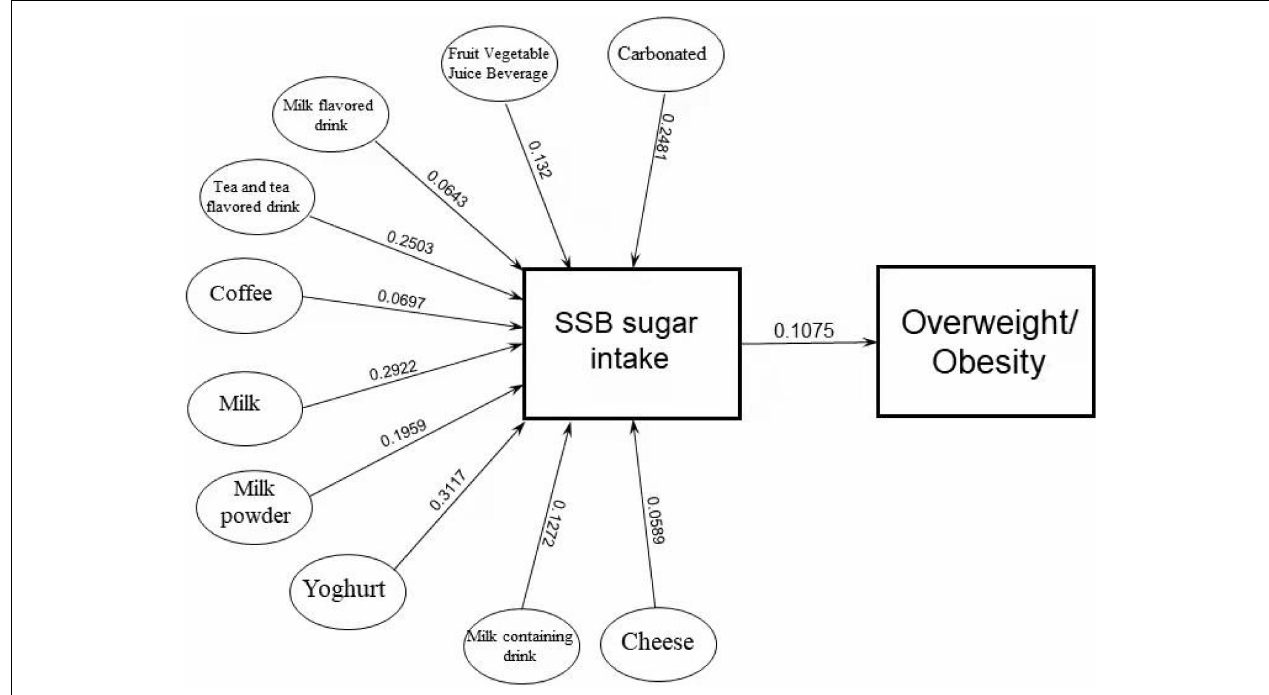
FIGURE 4 | Standardized estimation of the relationship of types of SSB, SSB sugar intake, and